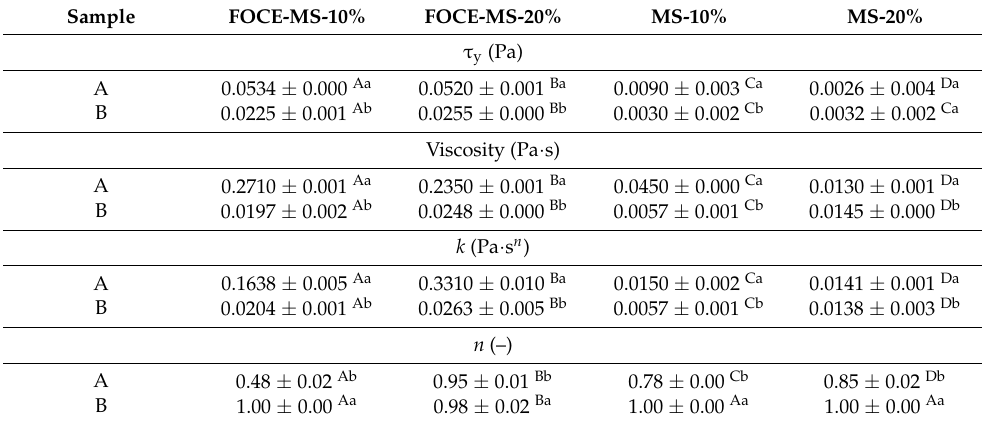
Table 7. Rheological parameters of emulsions before spray drying (A) and after reconstitution (B), based on